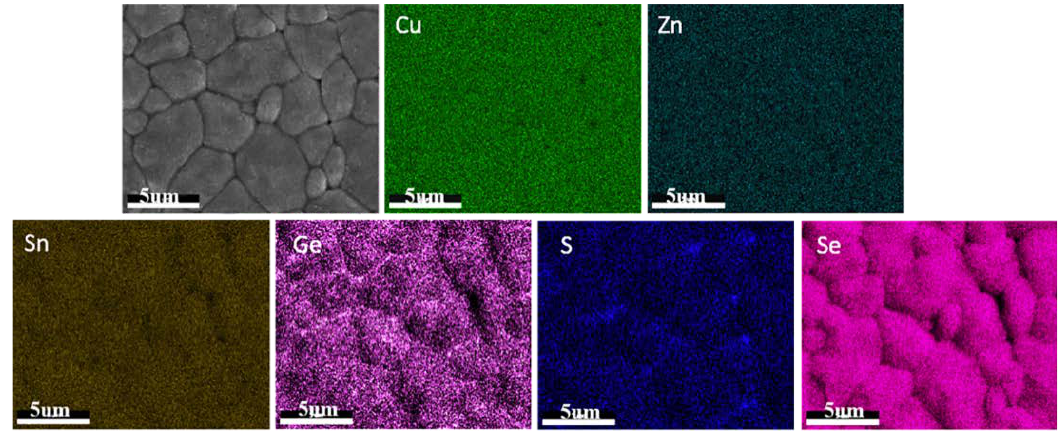
Figure 4. Element mapping analysis of the CZTGSSe film.